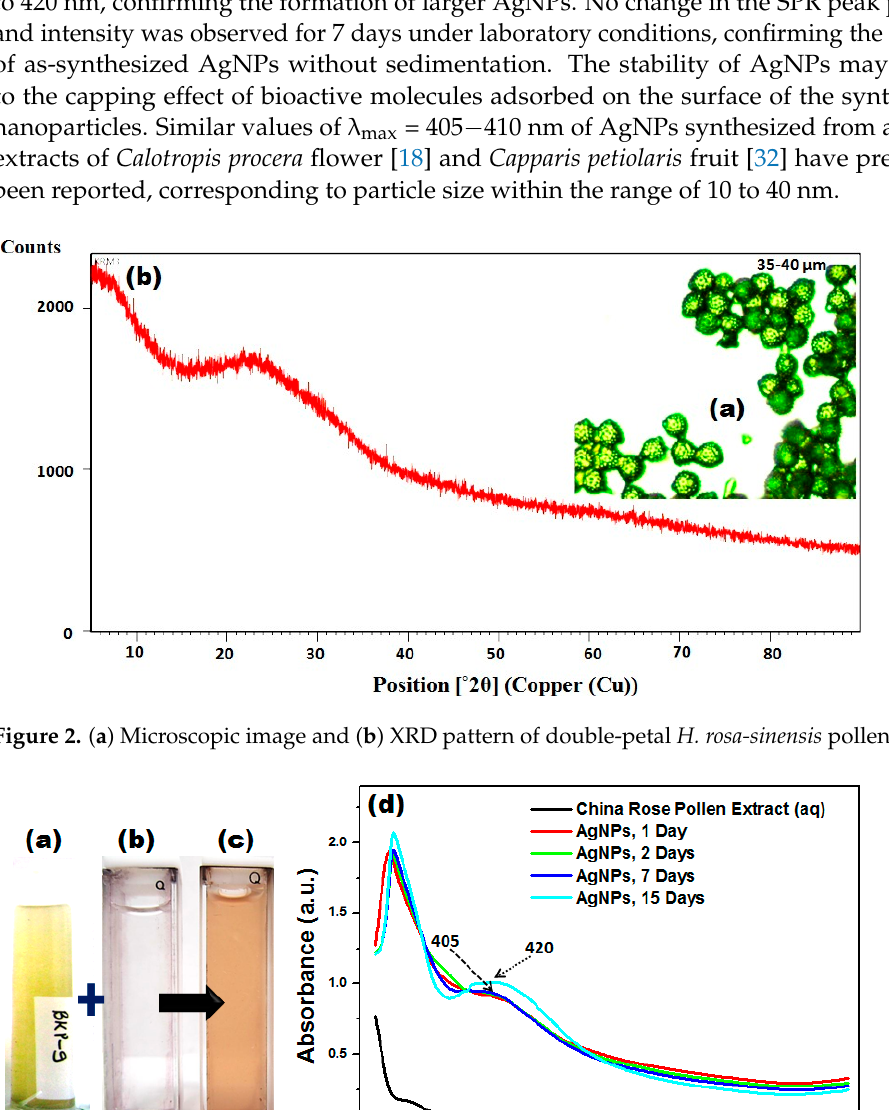
Figure 4. DLS pattern of as-synthesized AgNPs. 3.5. TEM–SAED Studies of AgNPs The shape of particles and the average diameter were determined from the micro- graphs by TEM. In Figure 5a–d, TEM analysis revealed the formation of spherical and non-agglomerated AgNPs of size ranges from 10 to 50 nm. The corresponding size distri- bution histogram of the AgNPs seen in the TEM image (Figure 5a) was analyzed manually with the ImageJ software. It demonstrated that the mean size of the AgNPs was 25.4 ± 13.1 nm (Figure 5b). Other HR-TEM was also performed at a resolution of 50 nm and it re- vealed that the AgNPs were mainly spherical in shape (Figure 5c,d). A slight heating can provoke a fast reaction and favors the reduction of Ag+ ions in the formation of nuclei [16,24]. We suggest that the organic layer encapsulates the AgNPs and inhibits the ag- glomeration of AgNPs. The SAED analysis also provides additional supporting infor- mation (Figure 5e) and was performed from a spherical AgNPs indicated bright spots,